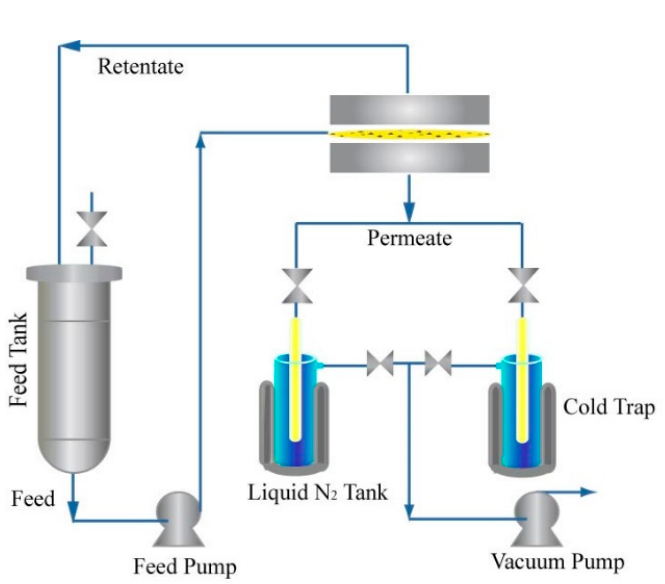
Figure 2. The schematic of the pervaporation